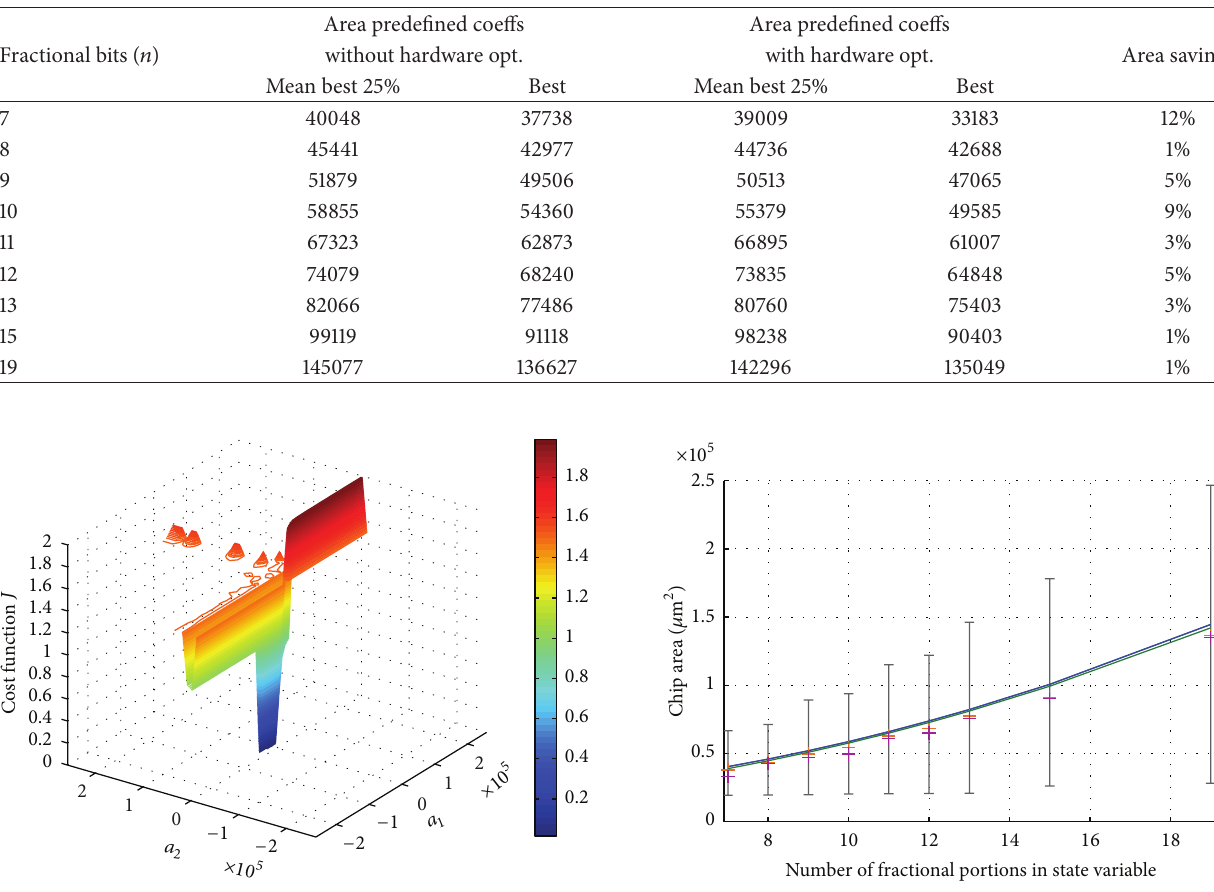
Table 5: Chip area in 𝜇 m 2 for predefined coefficients (constant at synthesis time) with and without multi-objective optimisation for hardware efficiency (fixed-point). The mean is computed out of the best 25% solutions within the final population. Populations size is 100.